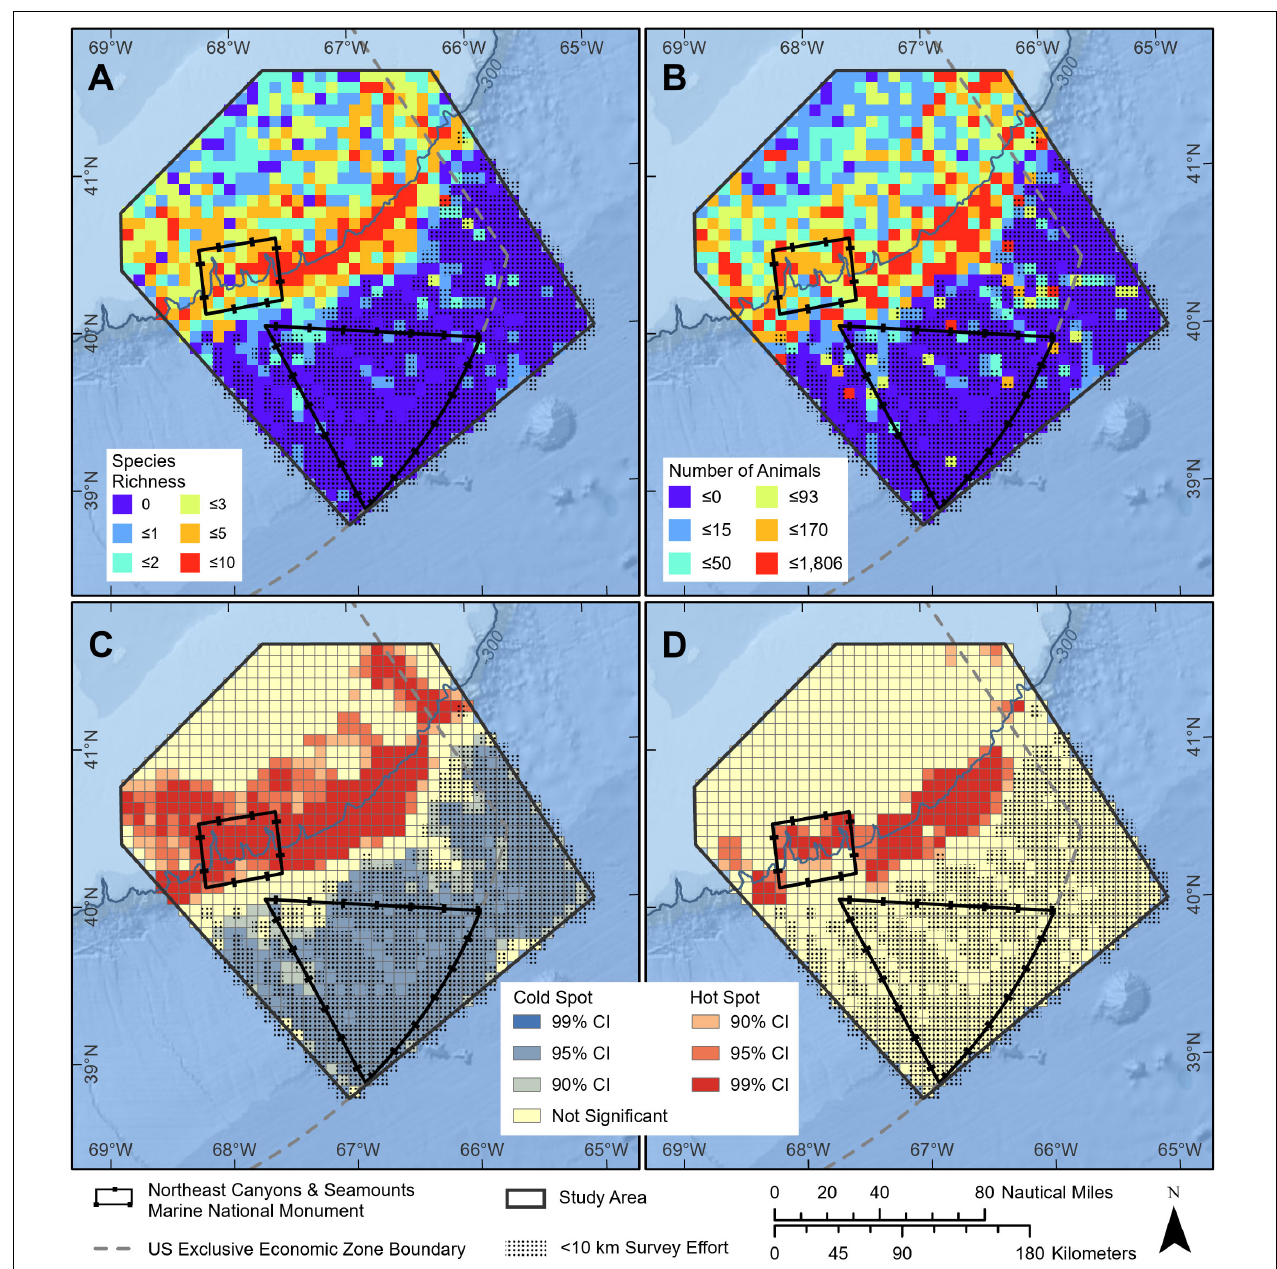
FIGURE 3 | Patterns in the distribution of marine mammal species in the monument region (slides are based on Kraus et al., 2016 with designated boundary configuration). (A,B) Marine mammal distribution showing species richness and total number of individuals for all marine mammals as a heat map. (C,D) Hot spot statistical analysis of species richness and numbers of marine mammals, with hot spots based on significantly higher values than surrounding areas. Note hot spots over canyon heads. Low values over seamounts is due in part to low survey effort. Supplementary Appendix 1 summarizes details of the geospatial analyses presented